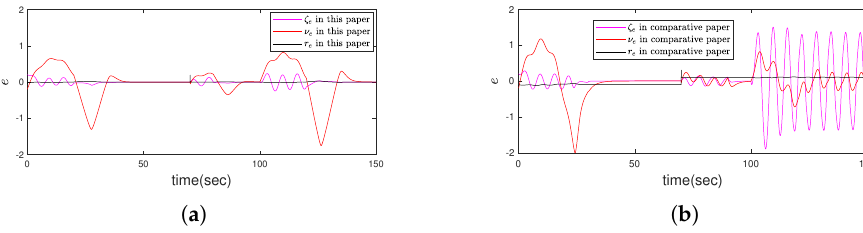
Figure 3. ( a ) The response curves for velocity errors in this paper. ( b ) The contrastive curves for velocity errors in method that ignores the effect of thruster saturation respectively in